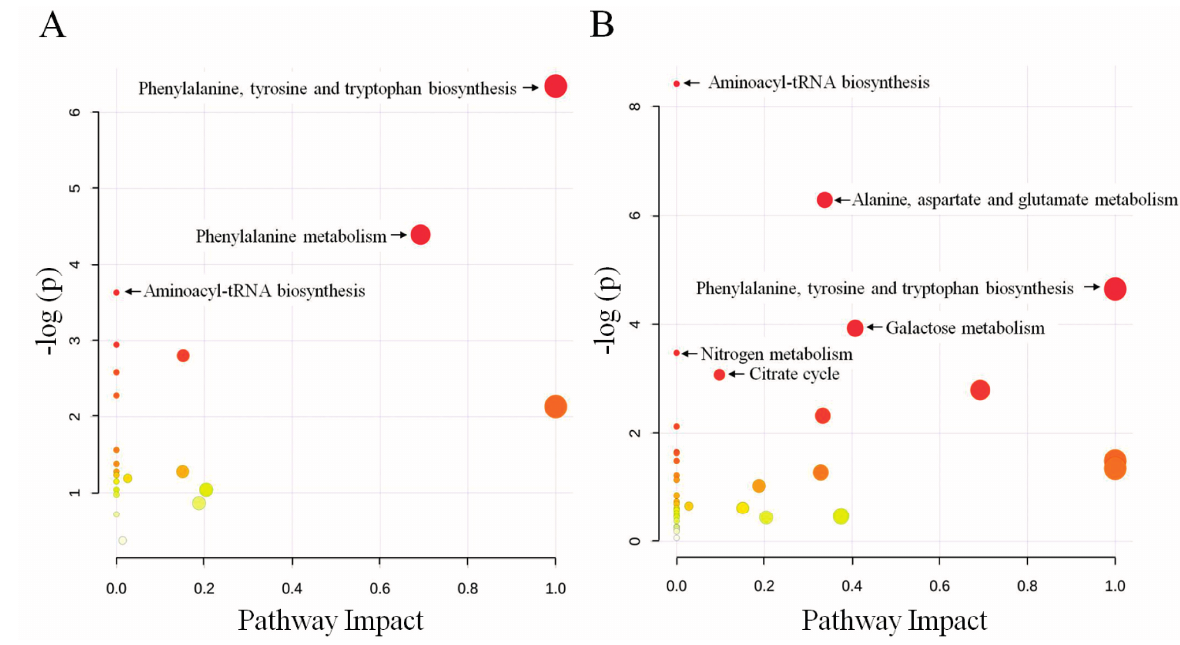
Figure 3. Schematic of the metabolome following the metabolite pathway mapping of the impacted metabolites identified after exposure to 20-Gy ( A ) and 40-Gy ( B ) radiation. The analysis was performed using the MetaboAnalyst